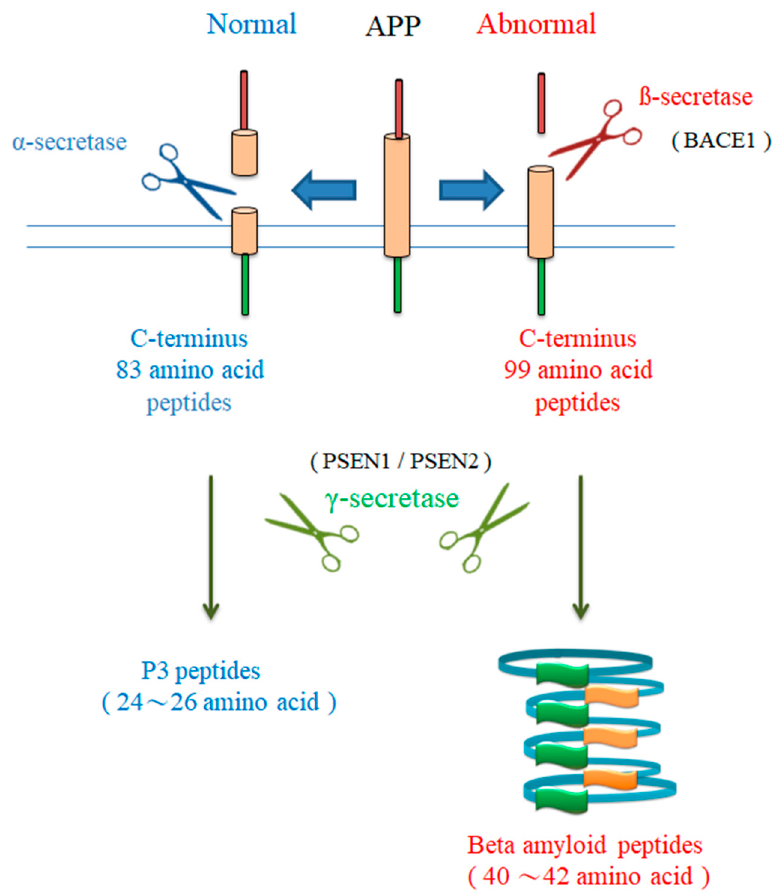
Figure 2. Beta-amyloid accumulation. In general, cleavage of beta amyloid precursor protein (APP) by alpha-secretase and γ -secretase cuts APP into P3 peptides (1–24~1–26 amino acids). However, once the gene generates mutations, such as APP and GSIS1 , PSEN1 gene expression increases, and the wrong cleavage is likely to occur and produce not easily metabolized peptide fragments (1–40~1–42 amino acids).